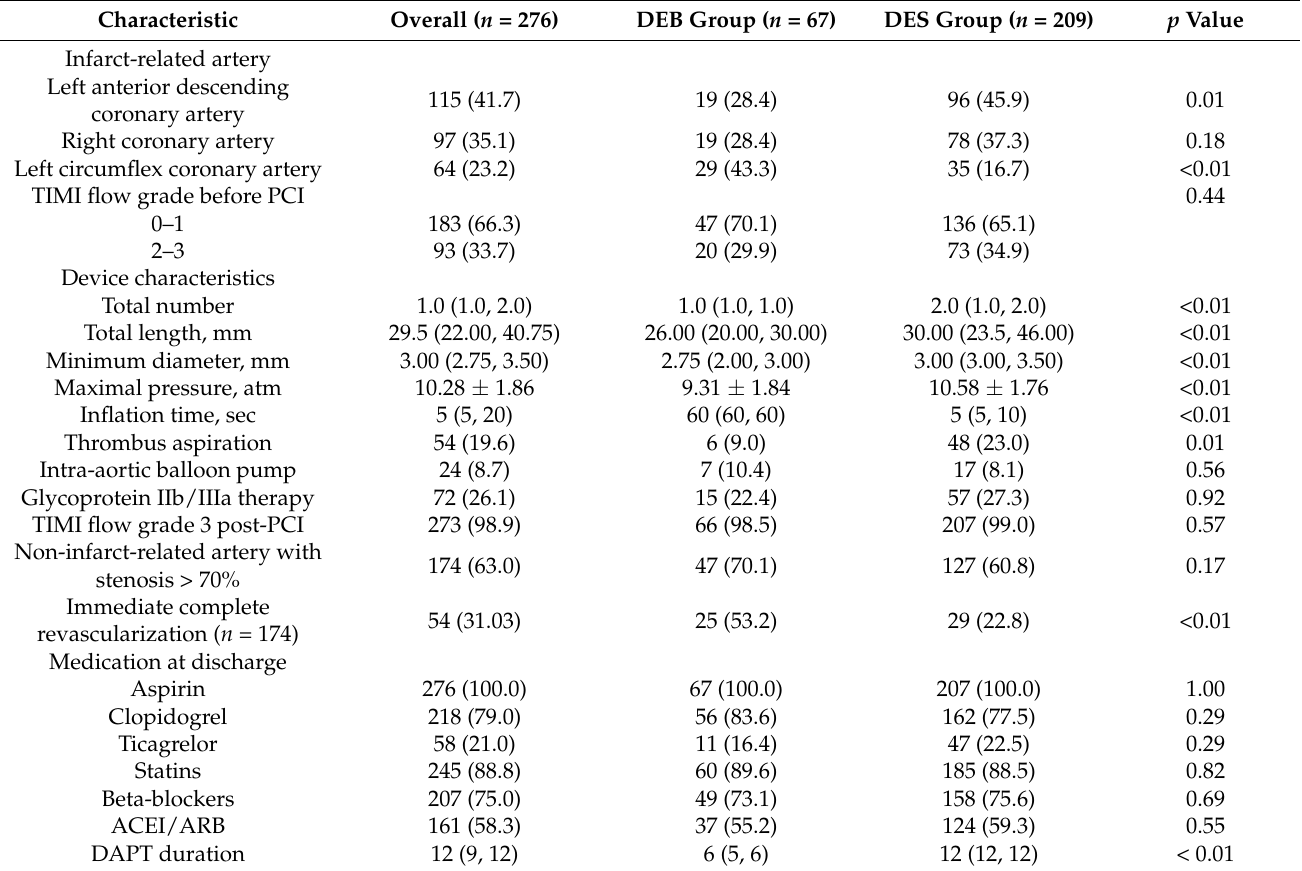
Table 2. Procedural and angiographic characteristics of patients.